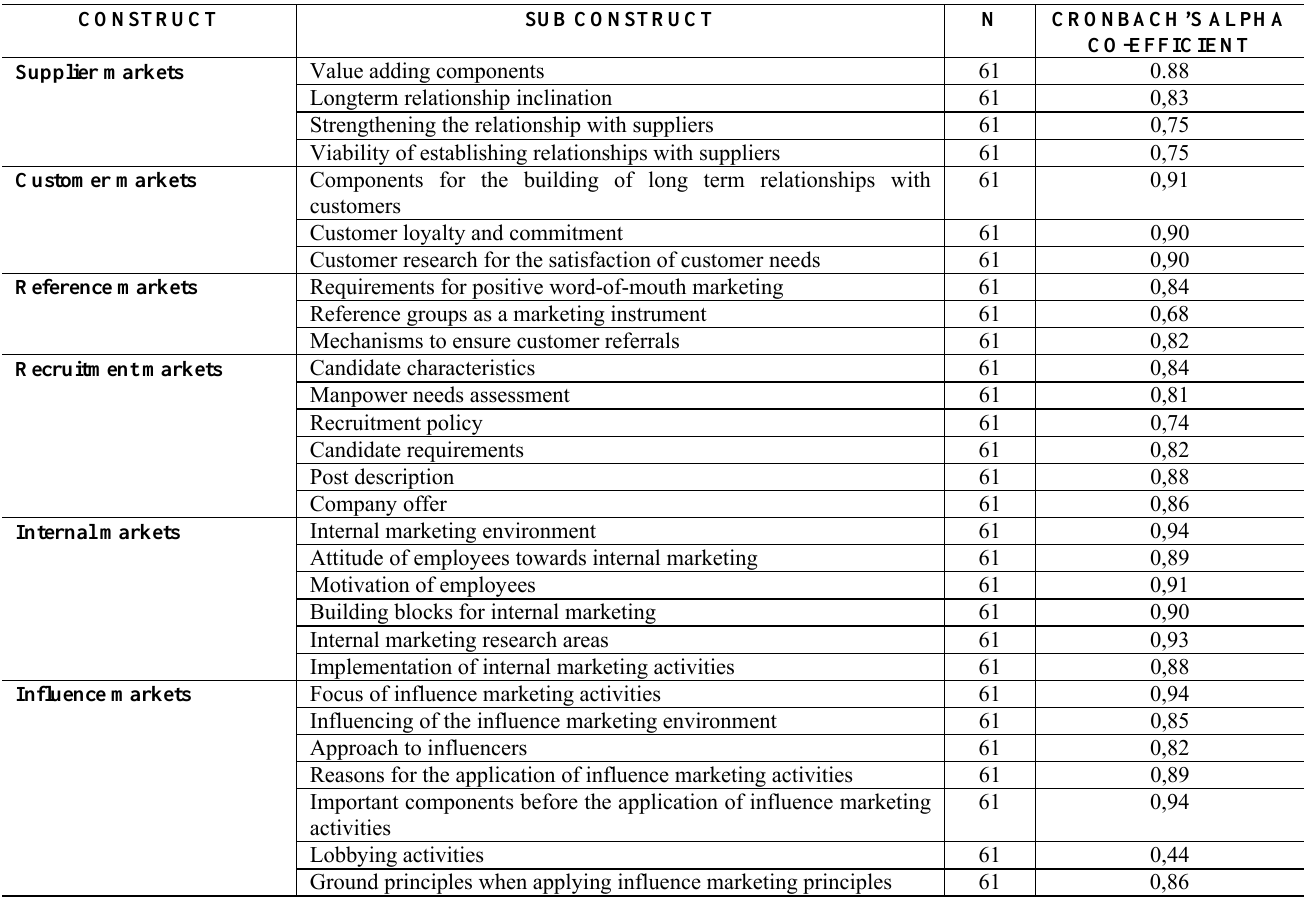
Table 1: Cronbach’s Alpha-values for the various relationship marketing constructs in the study